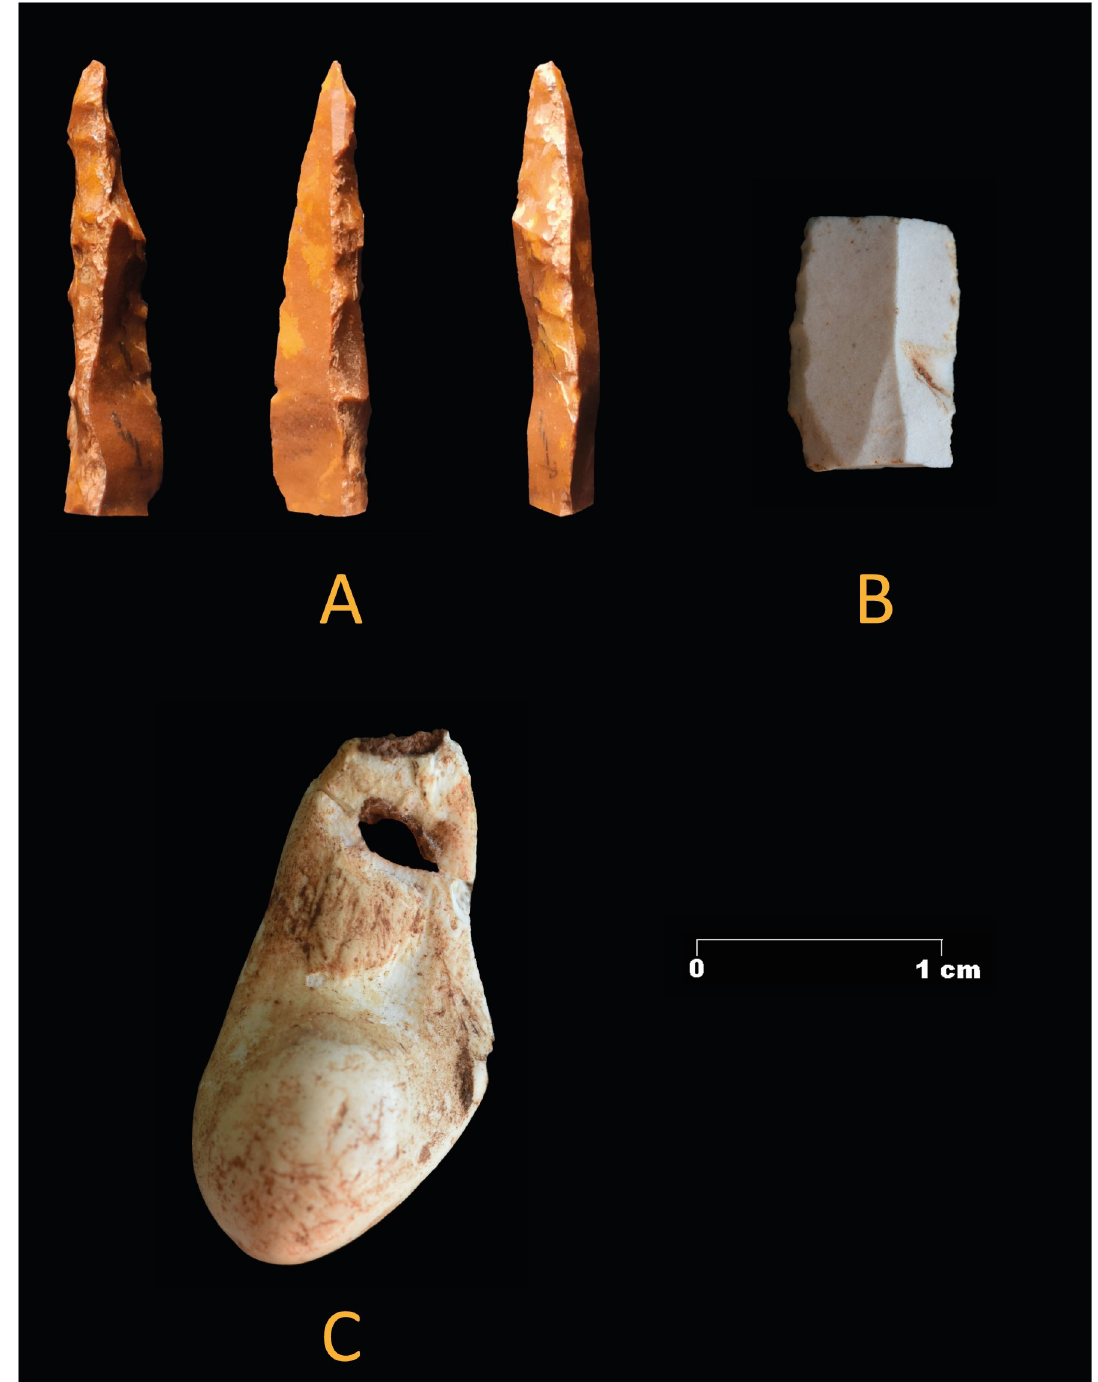
Fig 11. Special finds from layer 2, zone 5. a) broken tip of a Gravette point; b) medial fragment of a marginal inversely retouched bladelet; c) perforated red deer canine.